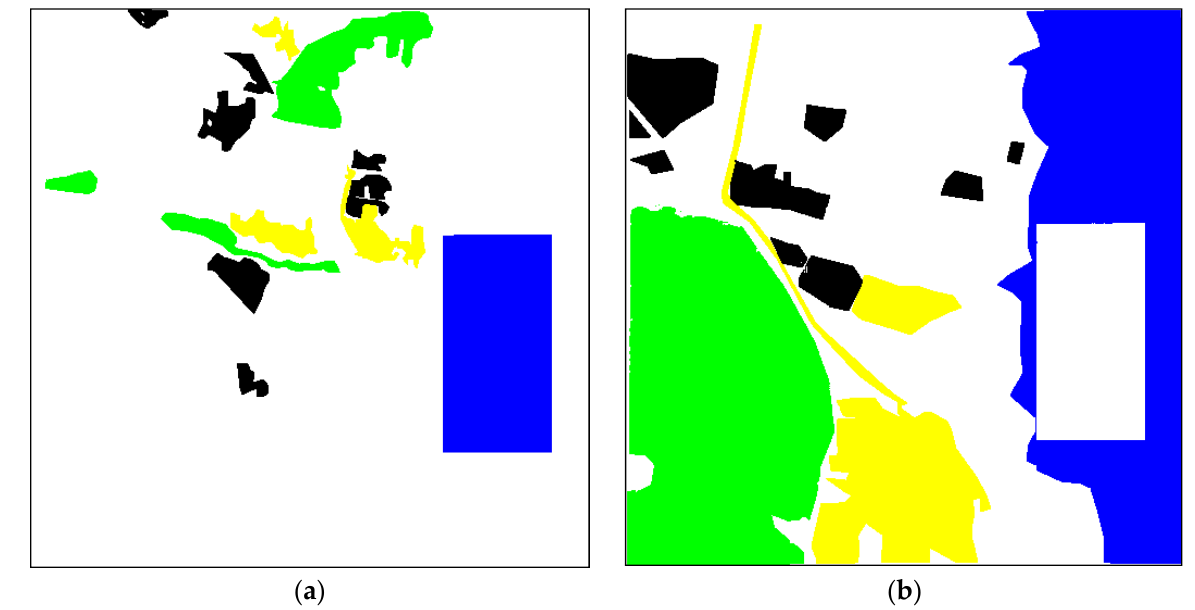
Figure 14. Three-channel fragments used for classifier training ( a ) and ground truth map ( b ) for the test image in Figure 12a.